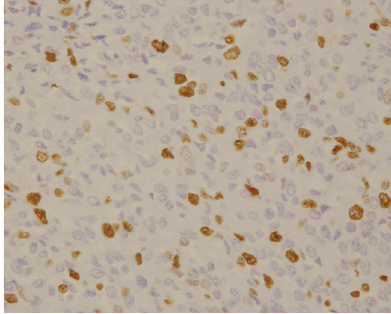
Figure 6: The specimen resected in 2000. There were more Ki-67 positive cells than Figure 5. Ki-67 labeling index was 20%.